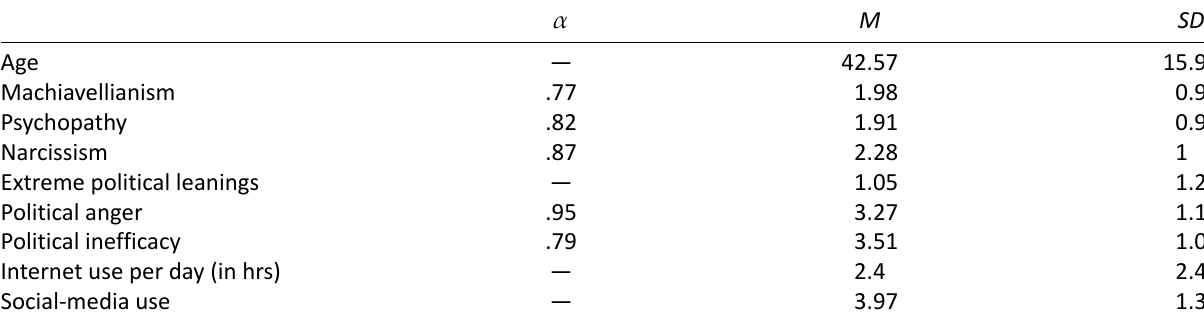
Table 1. Descriptives and reliabilities for parametric